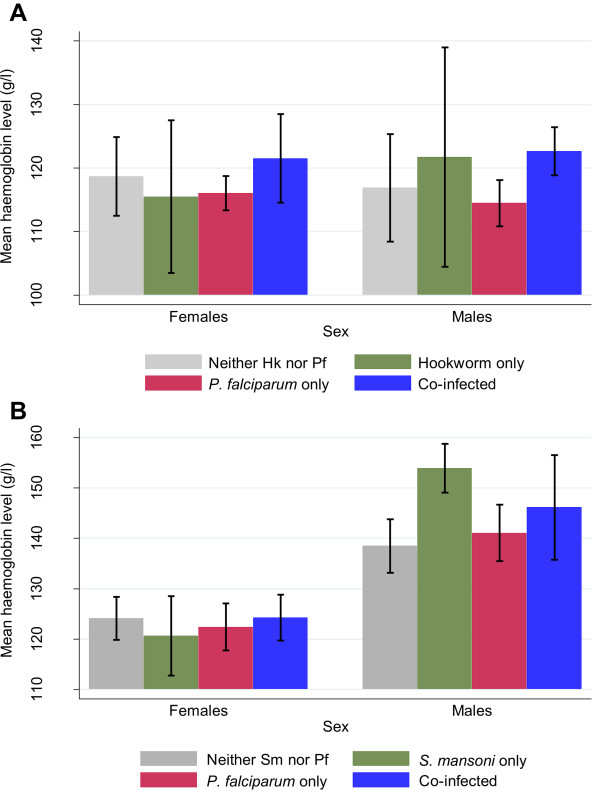
Comparison of mean haemoglobin levels in different age groups, stratified by sex in relation to helminth-P. falciparum co-infection from one-way ANOVA and Kruskal-Wallis test. A: Comparison of mean haemoglobin (Hb) level in children aged 5-11 years (n = 224) shown for both sexes with different infection categories for hookworm (Hk) and P. falciparum (Pf). One-way ANOVA analysis showed significant differences in Hb for the total sample (not shown, p = 0.008) and in males (p = 0.028) B: Comparison of mean Hb level in participants aged 16-39 years (n = 243) shown for both sexes with different infection categories for S. mansoni (Sm) and P. falciparum (Pf). Kruskal-Wallis test showed significant differences in Hb for the total sample (not shown, p = 0.021) and in males (p = 0.015). Pregnant women (n = 31) were excluded from the analysis since pregnancy significantly lowers the Hb levels. In this sample of women aged 16-39 years, pregnant women had a mean Hb of 113.5 g/l vs. 123.3 g/l in non-pregnant women (p = 0.001).